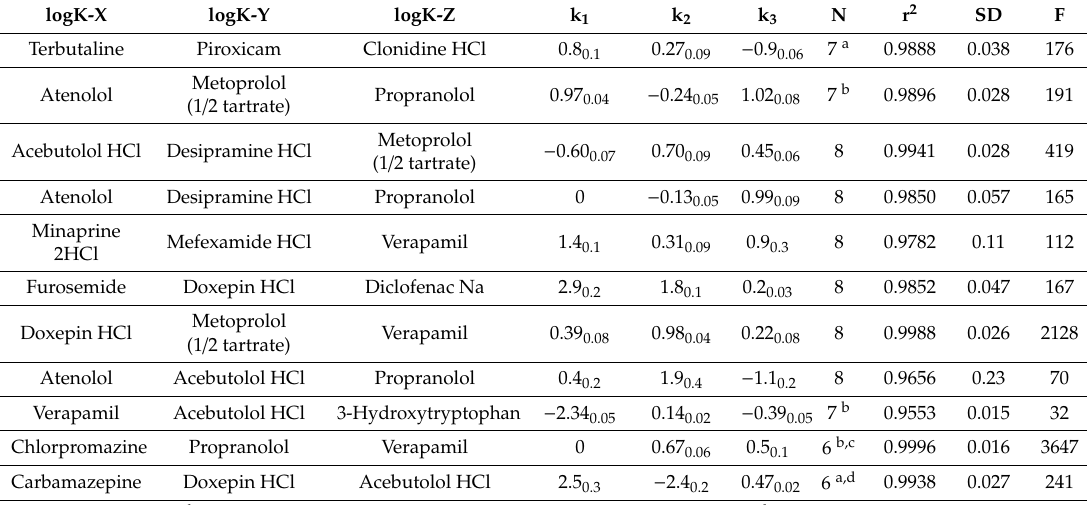
Table 3. Coe ffi cients and statistical characteristics of linear relationships between logarithms of partition coe ffi cients for various organic compounds in octanol-bu ff er systems of di ff erent ionic compositions (data from [21], see Table